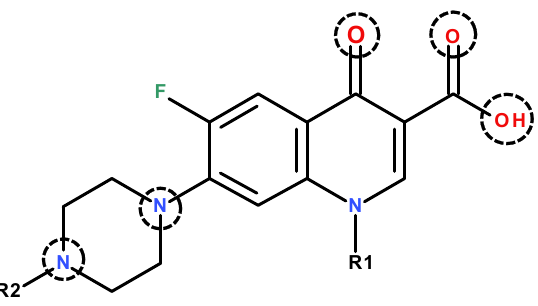
Figure 3. Donor atoms in the general structure of fluoroquinolones.